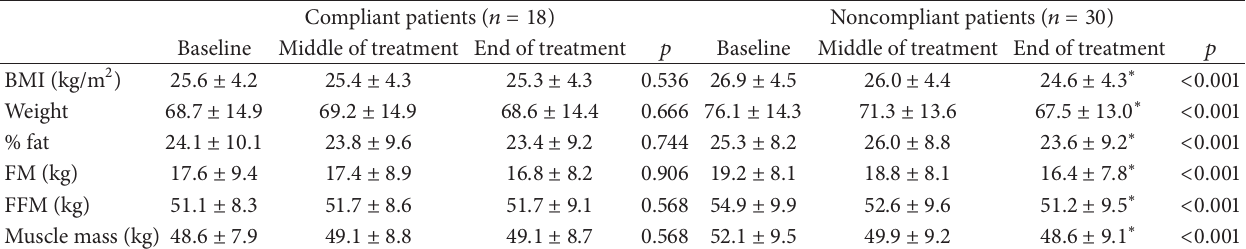
Table 3: Anthropometric and body composition parameters with respect to compliance.